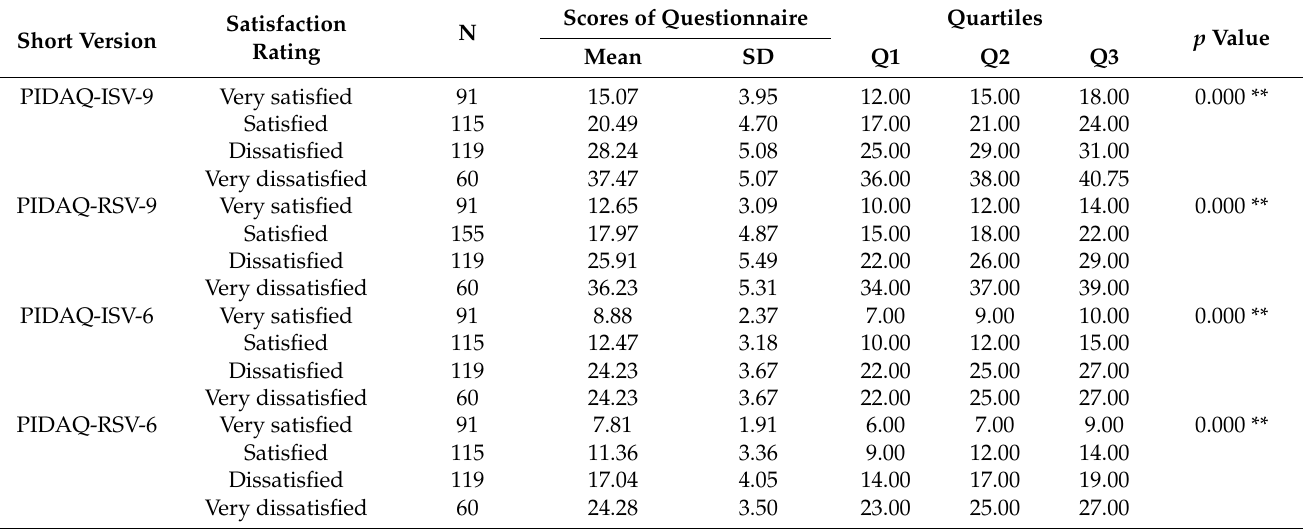
Table 11. The convergent validity: association between all short versions of Arabic PIDAQ with perceived satisfaction with dental appearance rank (n = 385).